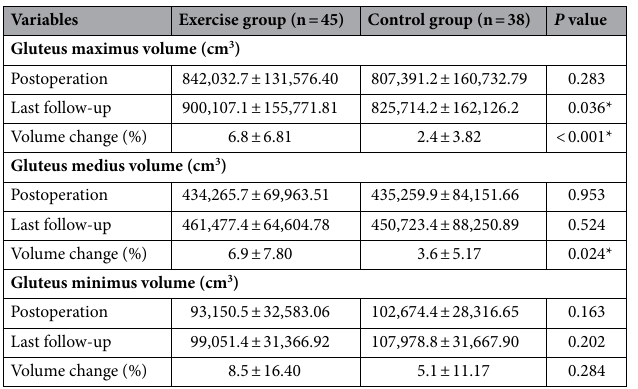
Table 4. Comparison of gluteal muscle volume between two groups. Data are presented as mean ± standard deviation. * p <